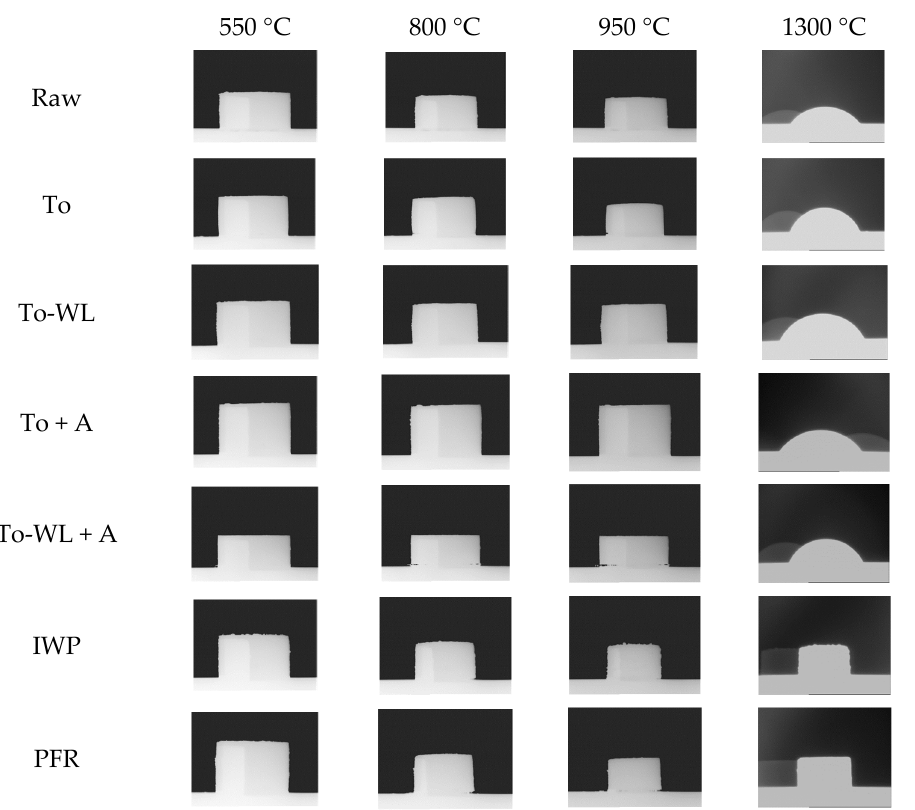
Figure 10. Snapshots recorded during ash fusion test. The change of the geometry of the pellets indicates first reactions or melting.